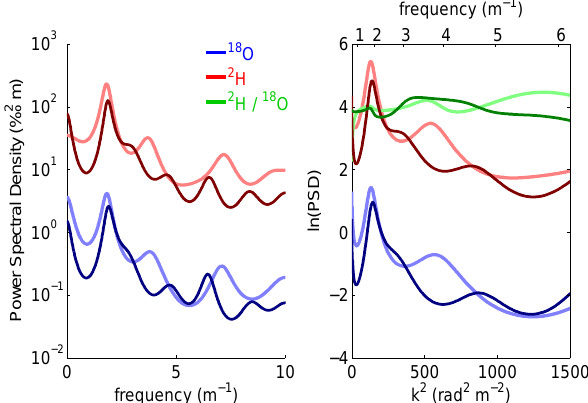
Figure 2. The power spectral densities of two stacked precipitation records retrieved from the GNIP database. In light colours the De- brecen data are given; dark colours refer to data from Vernadsky. The figure on the left shows the PSD as a function of frequency, whereas the figure on the right shows the natural logarithm of the PSD as a function of the wave number squared (bottom x